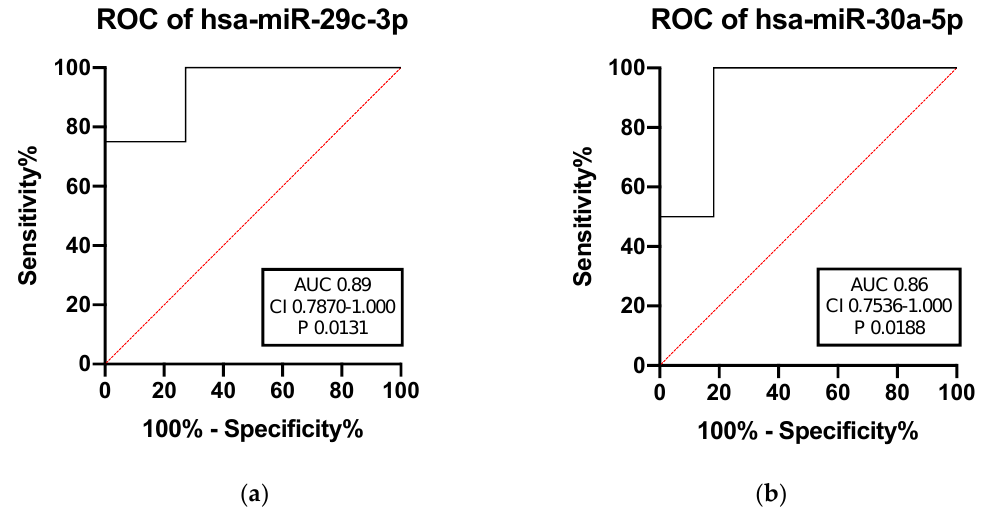
Figure 2. ROC curves analysis of circulating miR-29c-3p, ( a ) and miR-30a-5p, and ( b ) among ASSD patients with and without ILD. AUC: area under the curve. CI: confidence interval.